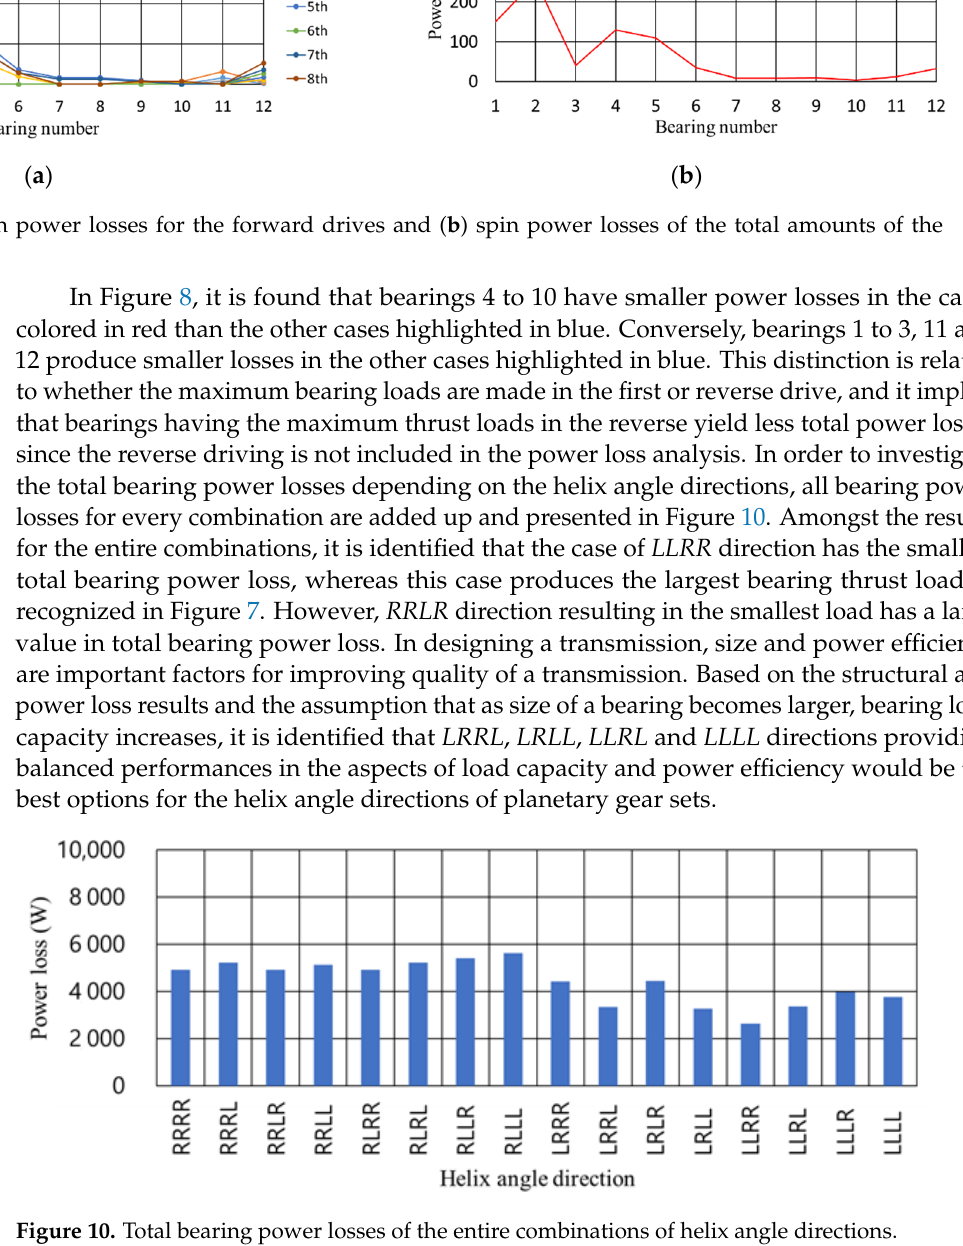
Figure 8. Bearing power losses of the entire combinations of helix angle directions. ( a ) RRRR/RRRL/RRLR/RRLL directions;